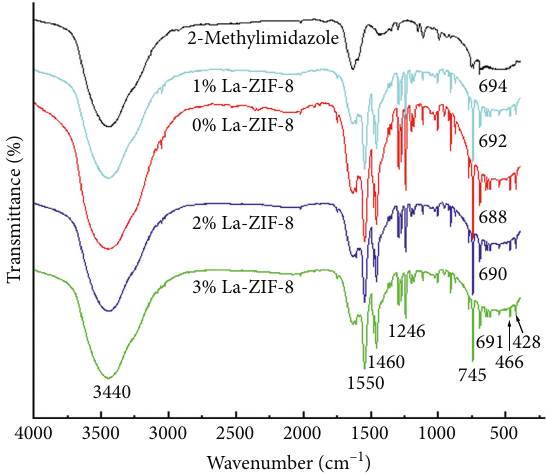
Figure 2: XRD patterns of ZIF-8 and La-ZIF-8. Figure